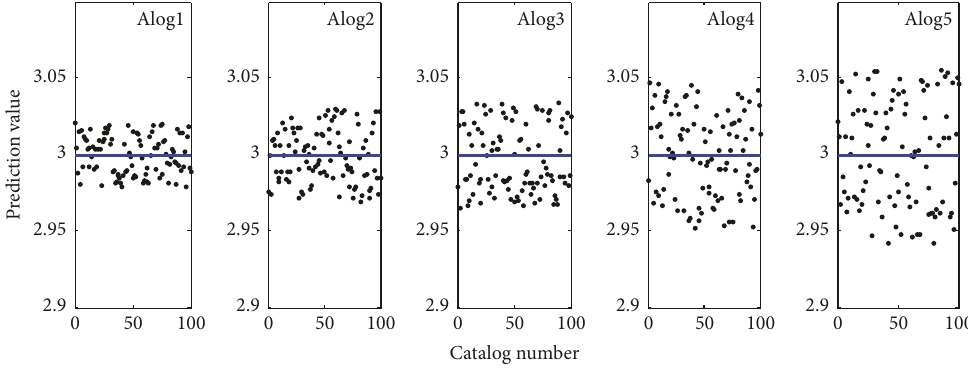
Figure 6: Prediction result for state 3.